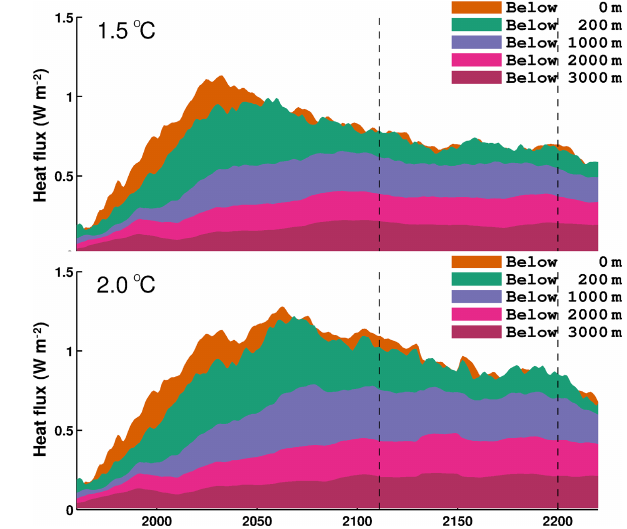
Figure 3. Ocean heat uptake as a function of time in the CPL- 15 (a) and CPL-20 (b) experiments. Shown is the heat uptake for depths 0–200m (orange shading), 200–1000m (green shading), 1000–2000m (blue shading), 2000–3000 (pink shading), and be- low 3000m (dark pink shading). Dashed vertical lines emphasize the time period analysed in this study. Units are in Wm − 2 .